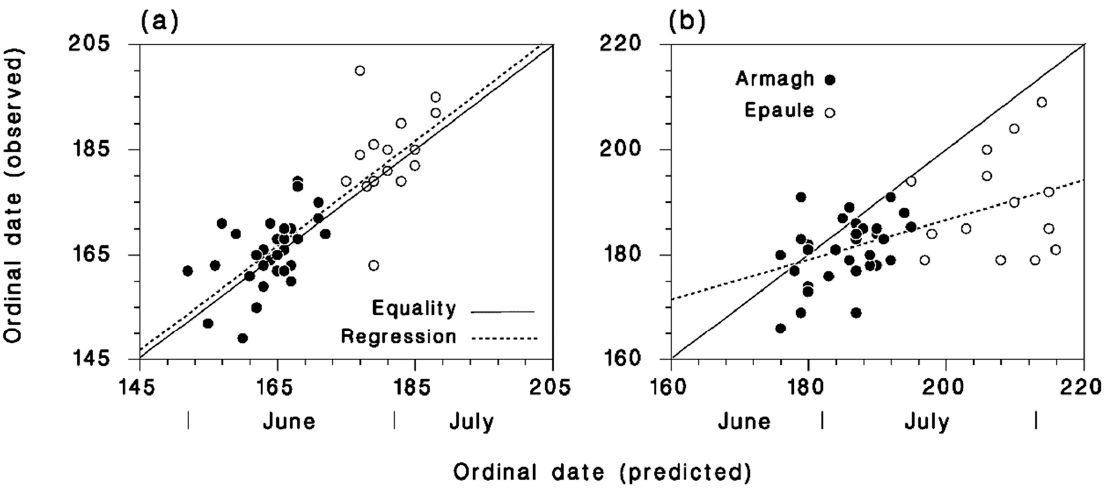
Figure 5. Comparison of the observed and predicted dates of ( a ) the start and ( b ) the peak of attacks on SBW larvae at Armagh ( ● ) and Epaule ( ○ ). Solid lines are equality, dotted lines are regression. The difference between observed and predicted dates of the start of A. interrupta parasitism is 4.5 days, very close to our estimate of a 5-day pre-larviposition period.